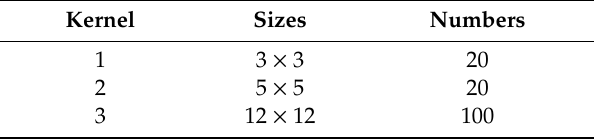
Table 4. Kernel sizes and numbers in this paper.